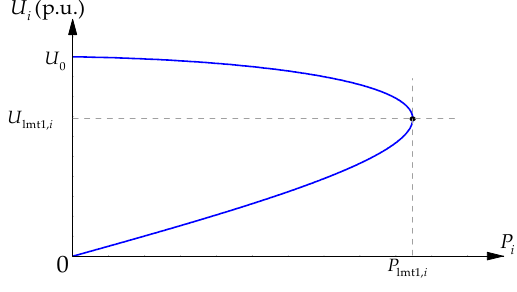
Figure 2. The P - U curve at bus i (parameters take typical values).